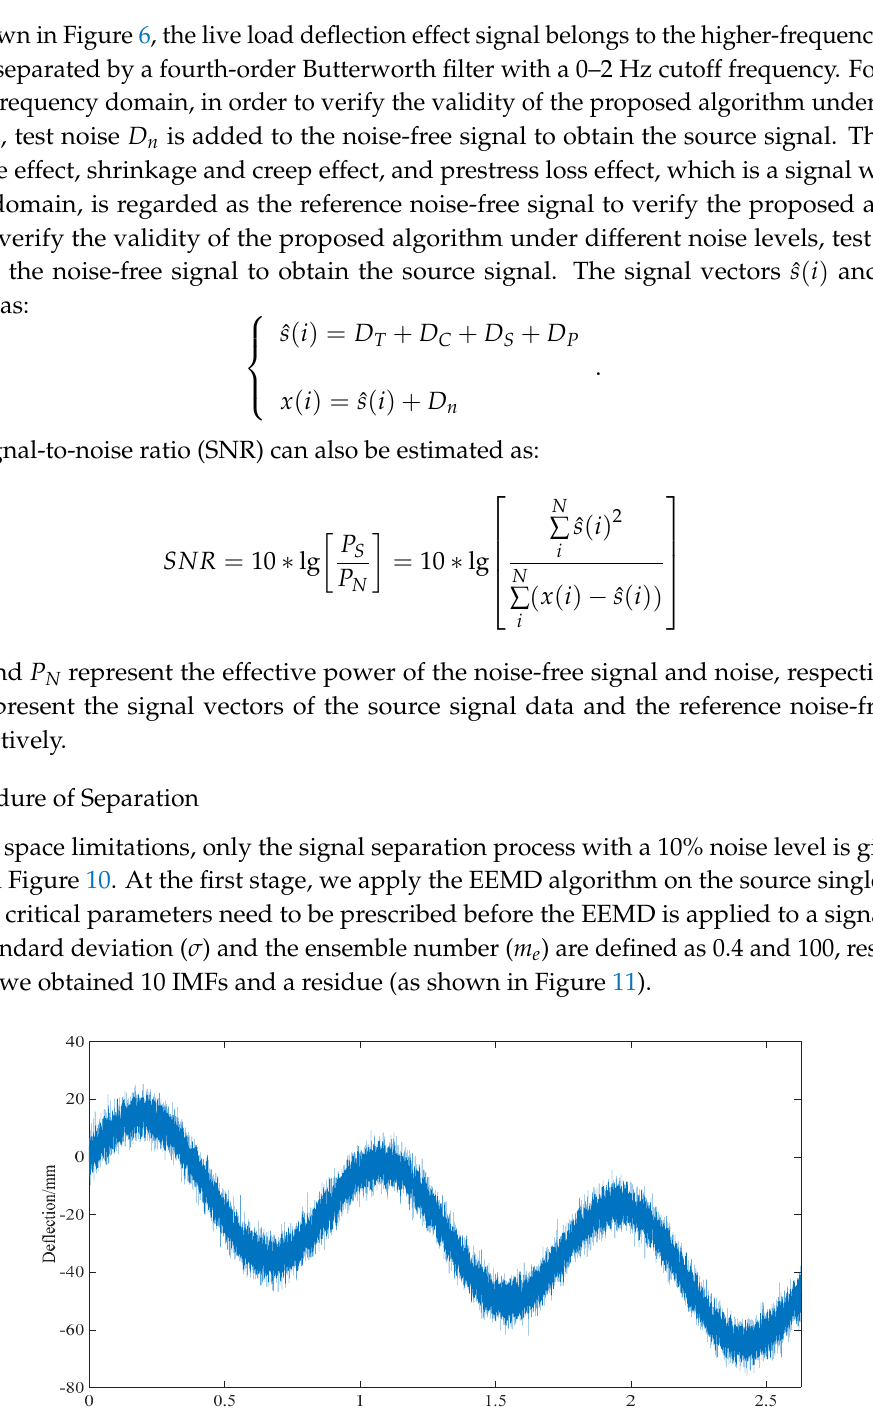
Figure 9. Deflection effect of the prestress loss ( D p ).